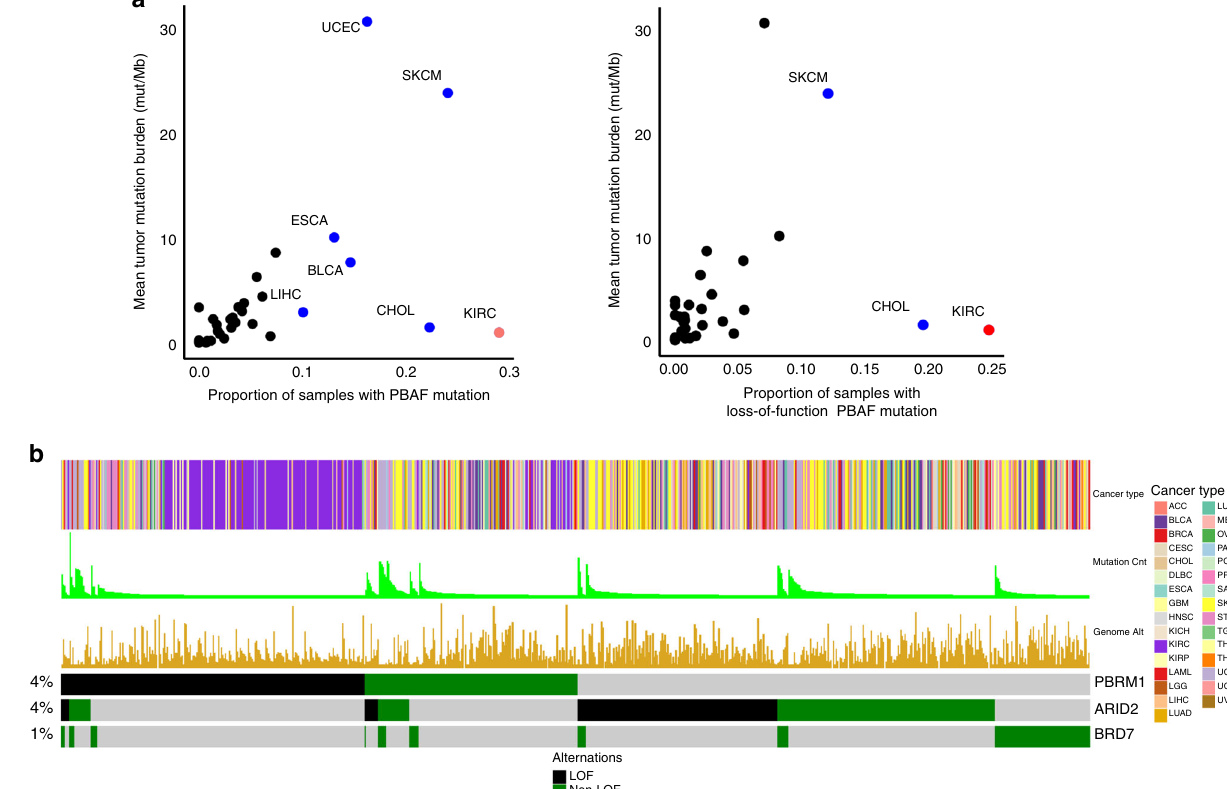
Fig. 1 PBAF complex mutations across The Cancer Genome Atlas (TCGA) n = 10,359. a All PBAF complex mutations as a function of mean tumor burden (left) and loss of function (LOF) only mutations (right). b OncoPrint plot demonstrating loss-of-function vs. non-LOF PBAF complex mutations across the TCGA.